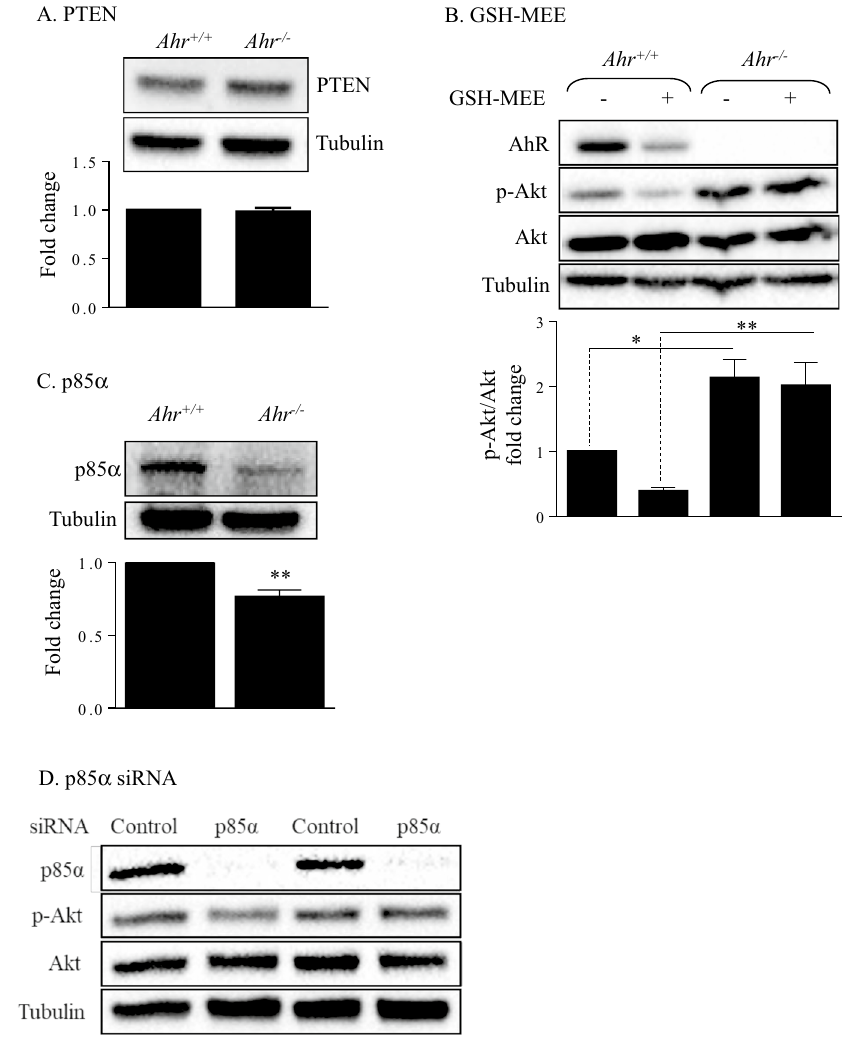
Figure 5. Expression of PTEN and p85α protein in Ahr +/+ a nd Ahr −/− MLFs. ( A , C ) Ahr +/+ and Ahr −/− MLF were serum-starved for 18 h and cellular protein was collected for Western blot analysis of ( A ) PTEN and ( C ) p85α expression. Depicted blots are representative of four independent experiments. Densitometric values were normalized to tubulin and are expressed as fold change relative to that of the Ahr +/+ groups. Results are expressed as mean ± SEM (*p < 0.05). ( B ) Serum-starved Ahr +/+ a nd Ahr −/− MLF were treated with 2 mM GSH- MEE or the vehicle control (H 2 O) for 1 h and cellular protein was collected for Western blot analysis of Akt phosphorylation. Depicted blots are representative of three independent experiments. ( D ) Ahr +/+ MLFs were transfected with non-targeting control siRNA or siRNA against p85α. Transfected cells were serum-starved for 18 h and cellular protein was collected for western blot analysis of Akt phosphorylation. Representative western blot is